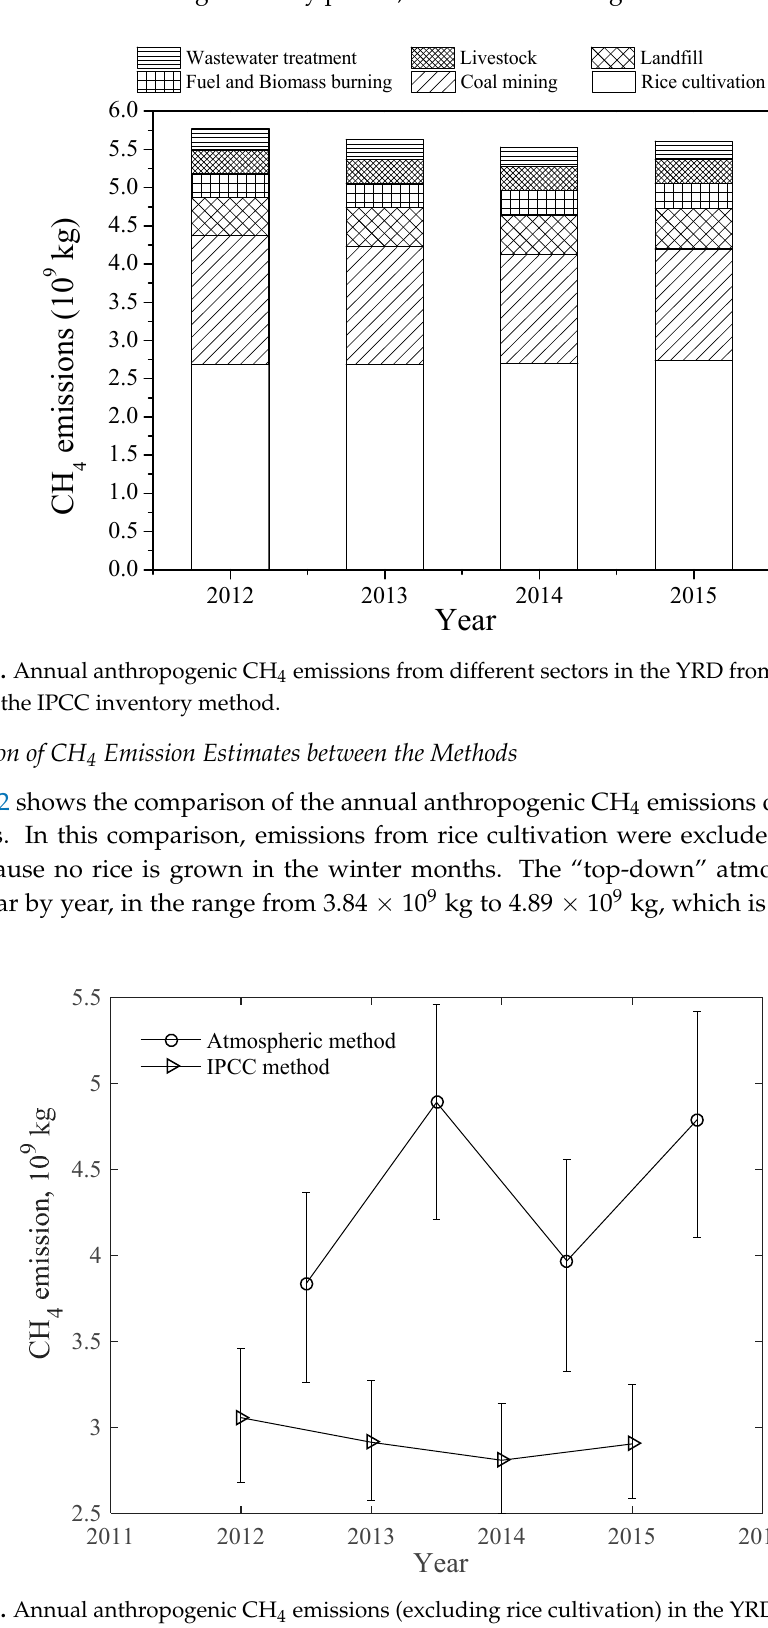
Figure 12. Annual anthropogenic CH 4 emissions (excluding rice cultivation) in the YRD from 2012 to 2015. Error bars indicate the uncertainty at a confidence level of 97.5%.